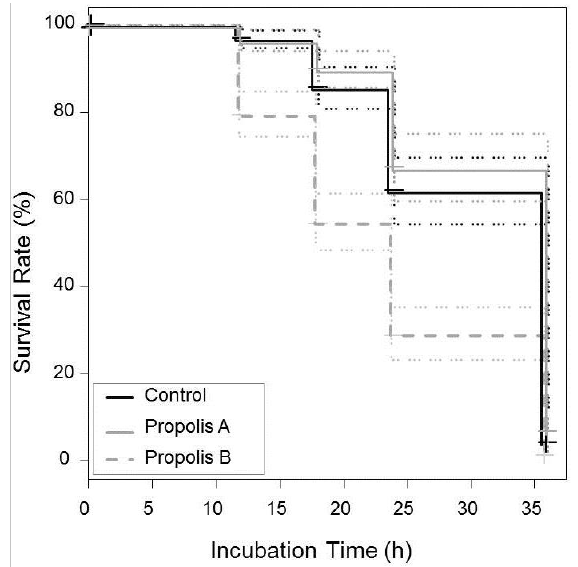
Figure 4. Kaplan-Meyer survival curves showing survival rates of Varroa destructor mites when exposed to propolis obtained from colonies treated with thymol (Propolis B = dashed line N = 58), not treated with thymol (Propolis A = gray line, N = 58) or not exposed to propolis (Control = black line, N = 58) under laboratory conditions. Dotted lines mark 95% confidence intervals.